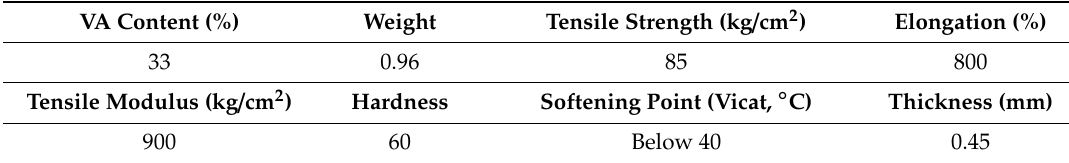
Table 2. Mechanical properties of ethylene vinyl acetate (EVA) sheet [6].